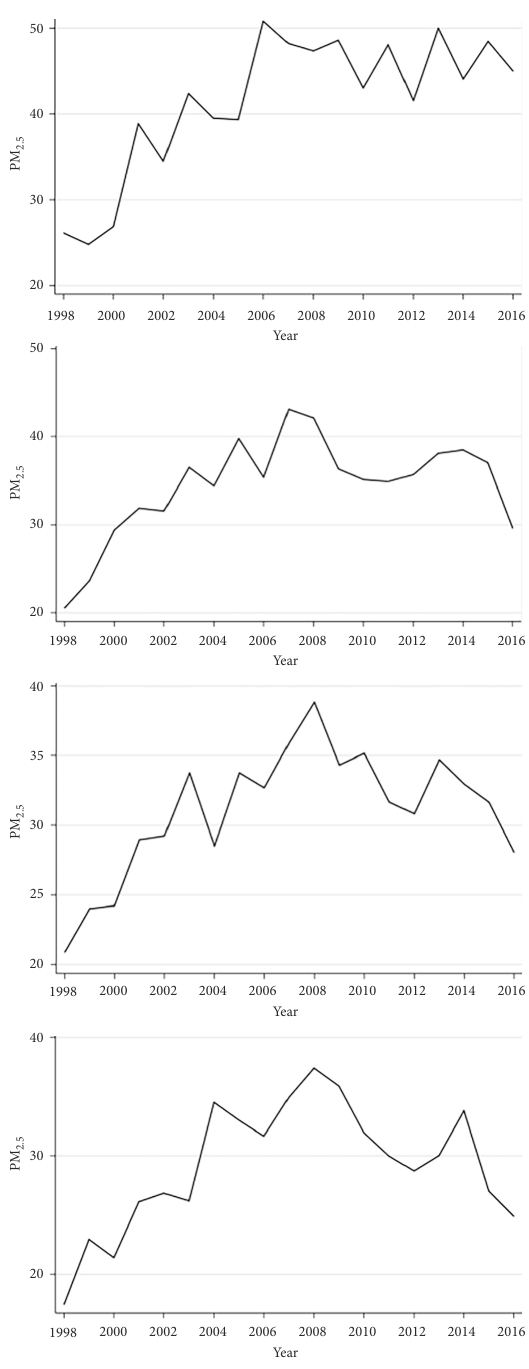
Figure 1. PM 2.5 trends in representative cities of Beijing-Tianjin-Hebei, Yangtze River Delta, and Pearl River Delta